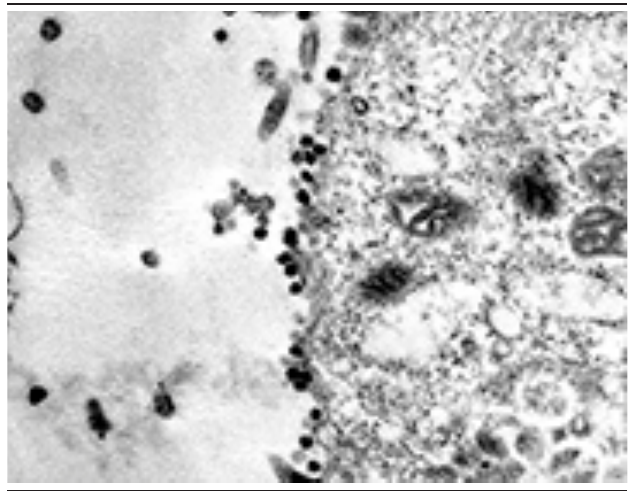
Produção de molde de inúmeras RNA- móleculas de